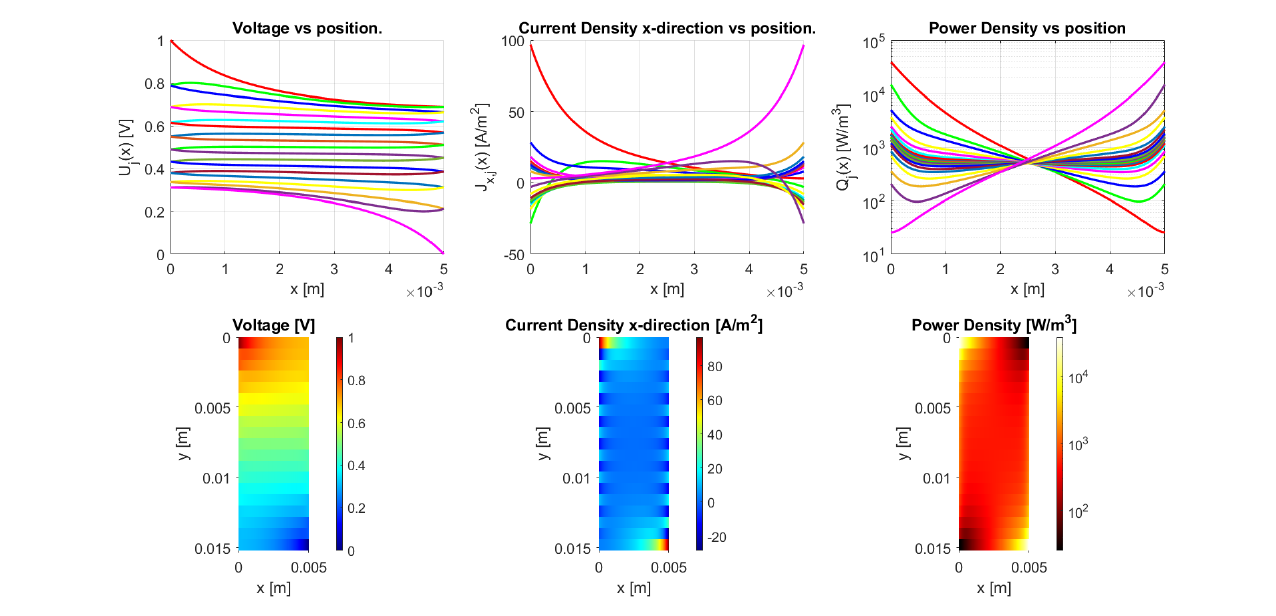
Figure 23. The model results for a meandering thick structure with with traxels of 5mm long and an aspect ratio of 3.04. The anisotropy ratio is taken to be Γ ≈ 1 by taking σ = 2 × 10 − 8 Ω m 2 . The voltage drop is mainly from top to